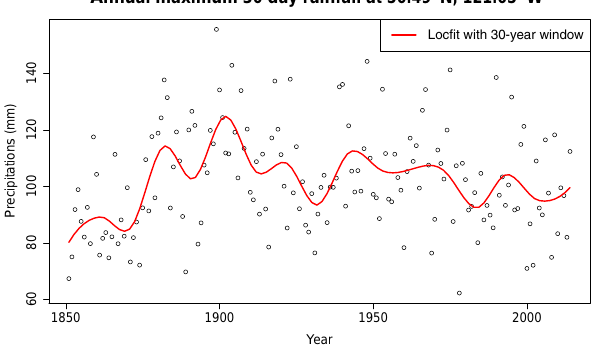
Figure 1. Time series of annual maximum 30-day precipitation for the Highland Valley open-pit copper mine in British Columbia, at latitude 50.49 ◦ N, and longitude 121.05 ◦ W, as estimated from the NOAA-CIRES 20th century climate re-analysis. This mine is one of the largest in the region, operating since the early 20th century. The highest precipitation for any consecutive 30-day period in each year is shown, together with a 30-year-moving window regression to illustrate the